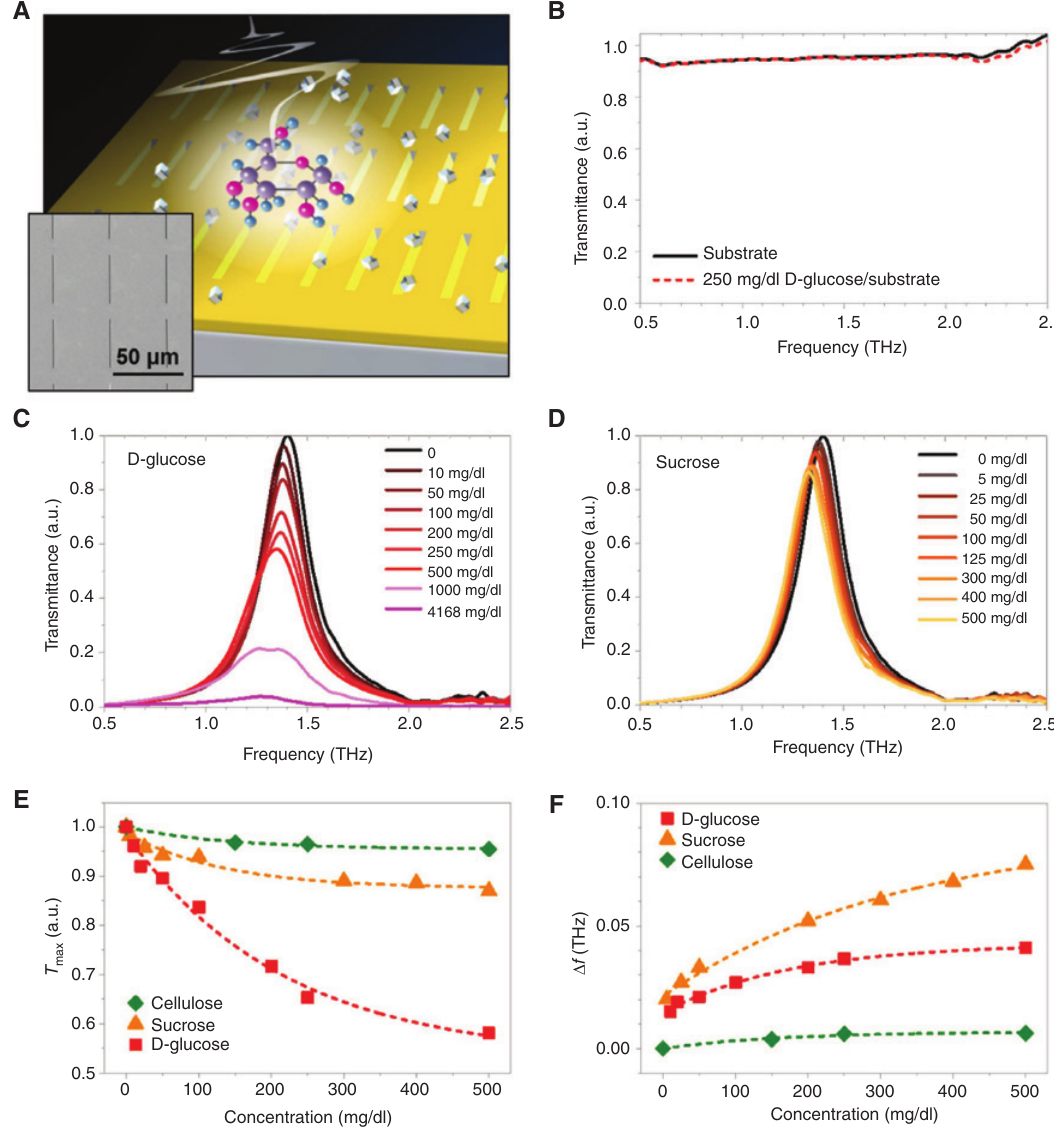
Figure 26: Detection of the sugar molecule by a THz metamaterial. (A) Schematic of the sugar molecule detection using a nano-antenna array-based sensing chip. (B) Normalized THz spectra measured for a bare substrate used as a substrate and 250 mg/dl of glucose on the same Si substrate. (C) Normalized THz spectra measured with the glucose antenna for d-glucose and (D) sucrose molecules. (E) The changes in the maximum values of the normalized transmittances are plotted for d-glucose, sucrose, and cellulose as a function of the molecular concentration level. (F) Frequency shifts at the maximum trans- mittance for three samples are plotted. This figure is reproduced from Ref.